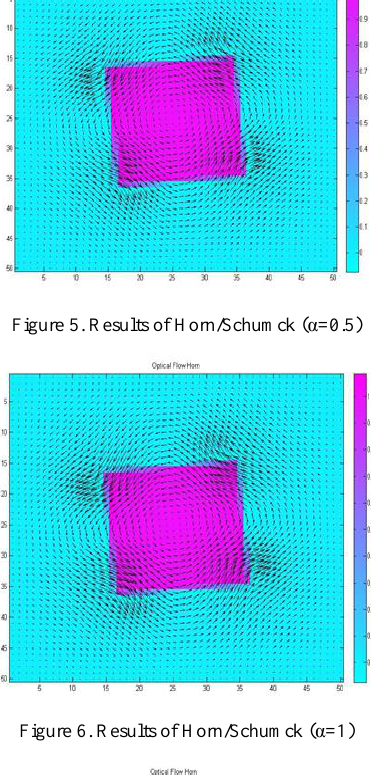
Figure 6. Results of Horn/Schumck (α=1)